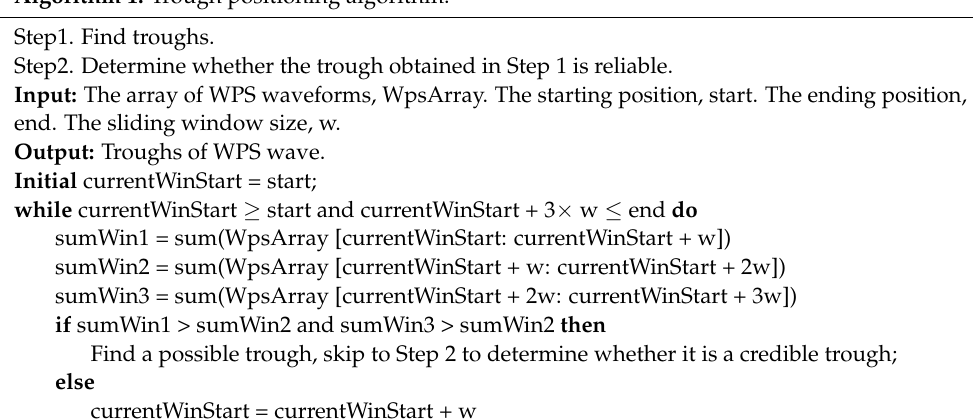
Algorithm 1. Trough positioning algorithm.